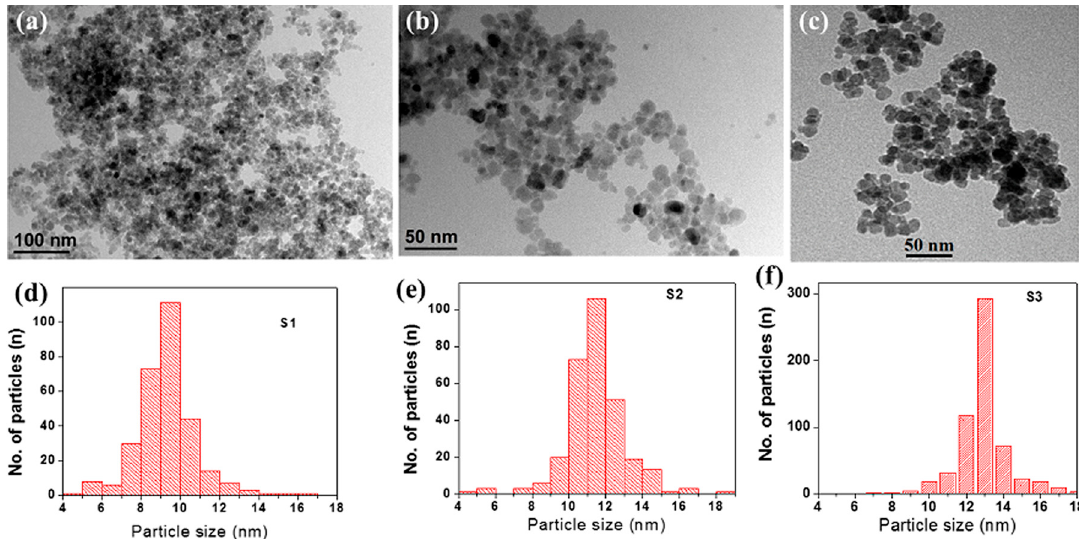
Figure 2. The transmission electron microscopy (TEM) images of samples ( a ) S1; ( b ) S2; and ( c ) S3. The particle size histograms of the samples ( d ) S1; ( e ) S2; and ( f ) S3. (Reproduced from [37]. Copyright Obaidat, I.M., et al., 2017.).